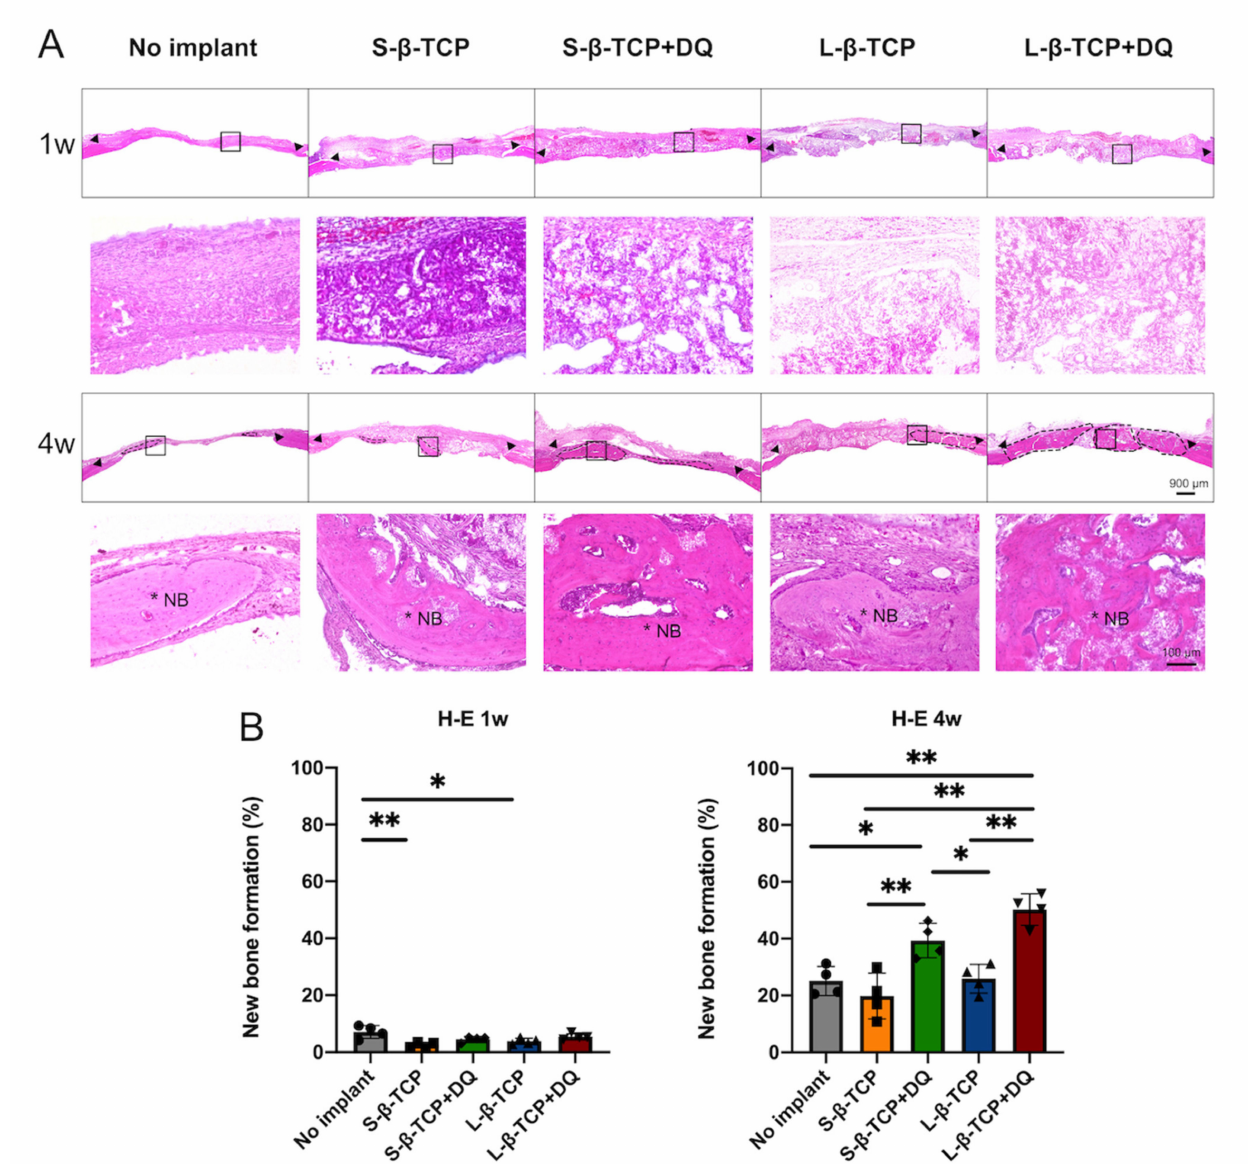
Figure 10. Histological evaluation of bone defects. ( A ) Hematoxylin-eosin (H-E) staining images of bone defects at one and four weeks after the operation. Upper parts represent low-magnification images (scale bar = 900 µ m); lower parts represent high-magnification images of the square in low-magnification images (scale bar = 100 µ m). Black broken lines represent area of newly formed bone. Black triangles represent the edge of created bone defects. * NB: New bone; ( B ) the histomorphometric analysis of newly formed bones utilizing samples of H-E staining. Mean with SD ( n = 4). * p < 0.05, ** p < 0.01: One-way ANOVA analysis with Tukey–Kramer method as post hoc